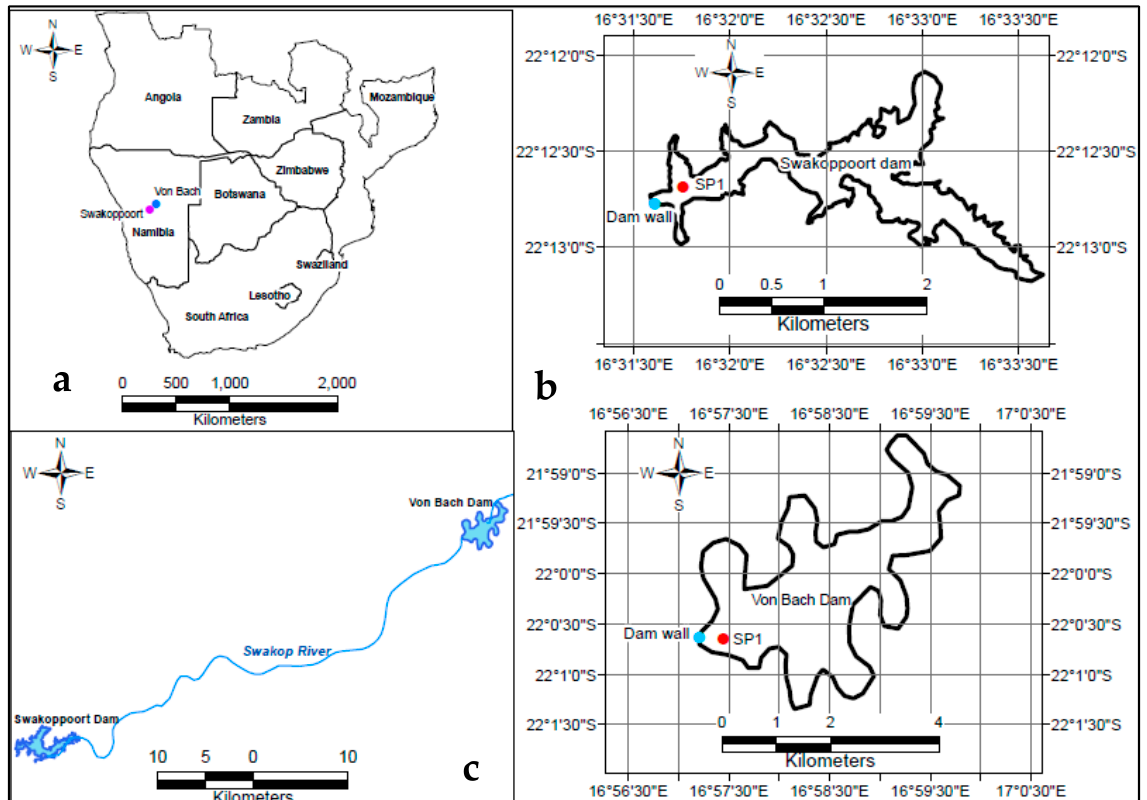
Figure 1. Maps indicating the ( a ) location of Namibia within Africa; ( b ) Swakoppoort and Von Bach dams located in central of Namibia, with sampling sites nearby the dam wall indicated; and ( c ) location of the Swakoppoort and Von Bach dams in the Swakop River. The maps were created with QGIS v 3.14 pi (Open Source Geospatial Foundation Project) using the Namibia Water Corporation dataset. Table 1. The main features of the Swakoppoort and Von Bach